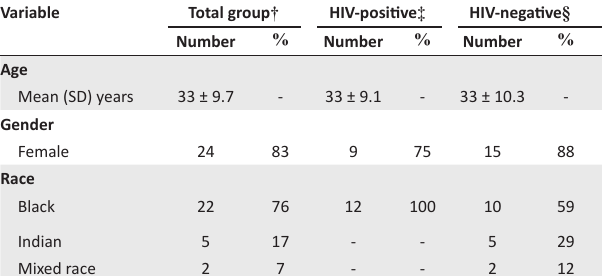
TABLE 1: Demographic data.